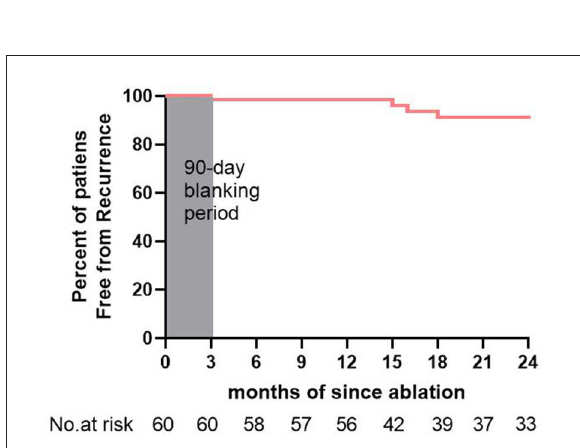
FIGURE6 Survival curve after the single catheter ablation